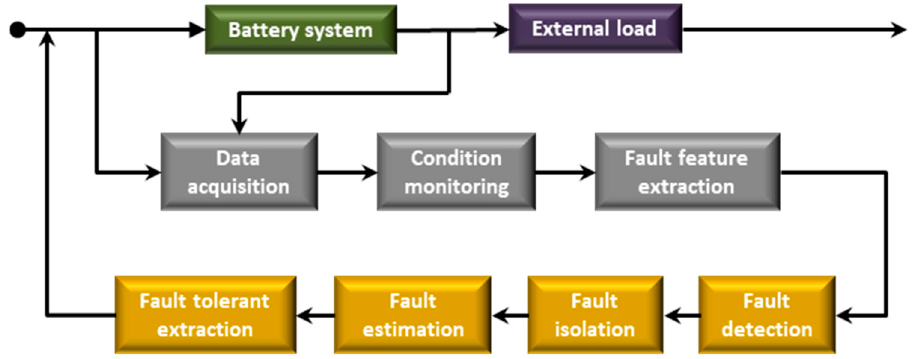
Figure 11. Fault diagnosis process of a battery system.